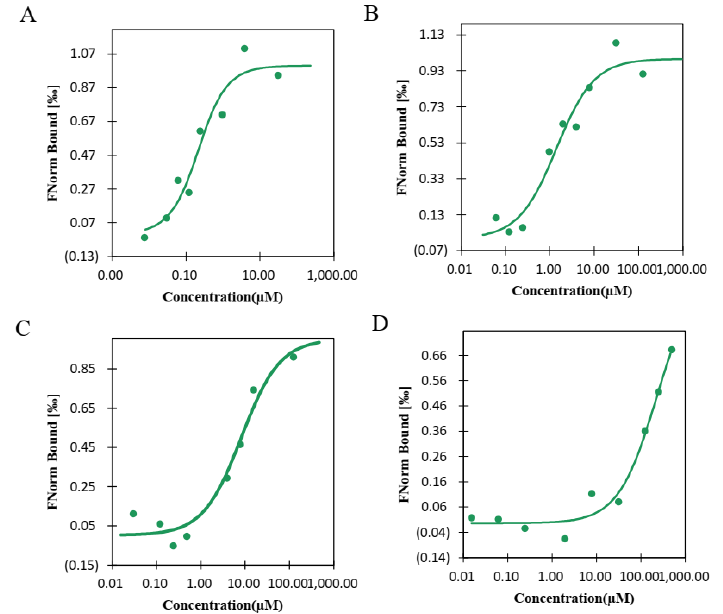
Figure 2. MST analysis of the interactions between SbSGT1 and plant hormones. ( A – C ): MST analysis of the interactions between SbSGT1 and IAA, SA, and ABA, respectively. ( D ): MST analysis of the interactions between BSA (bovine serum albumin) and IAA.